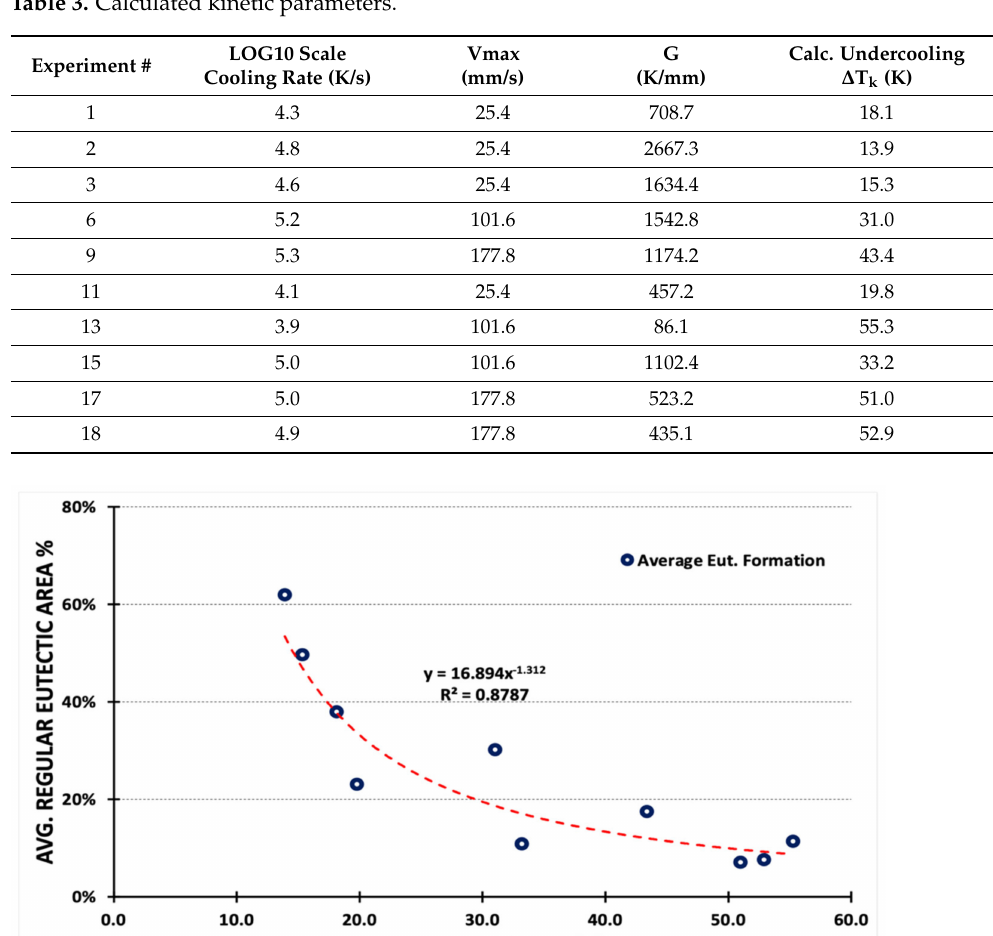
Table 3. Calculated kinetic parameters.